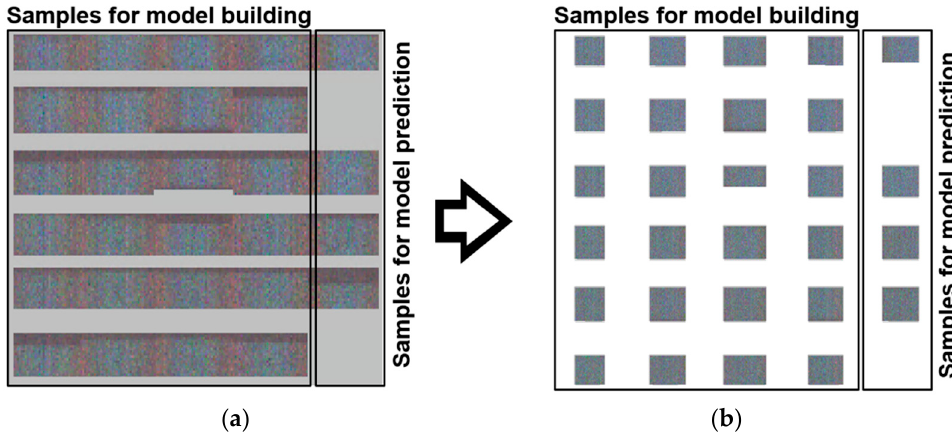
Figure 3. Hyperspectral raw images of 28 direct bonded copper samples on the left ( a ). Images after subtraction of the background on the right ( b ). In total, 24 samples were used for building the PLS-R model and four samples were used for prediction.